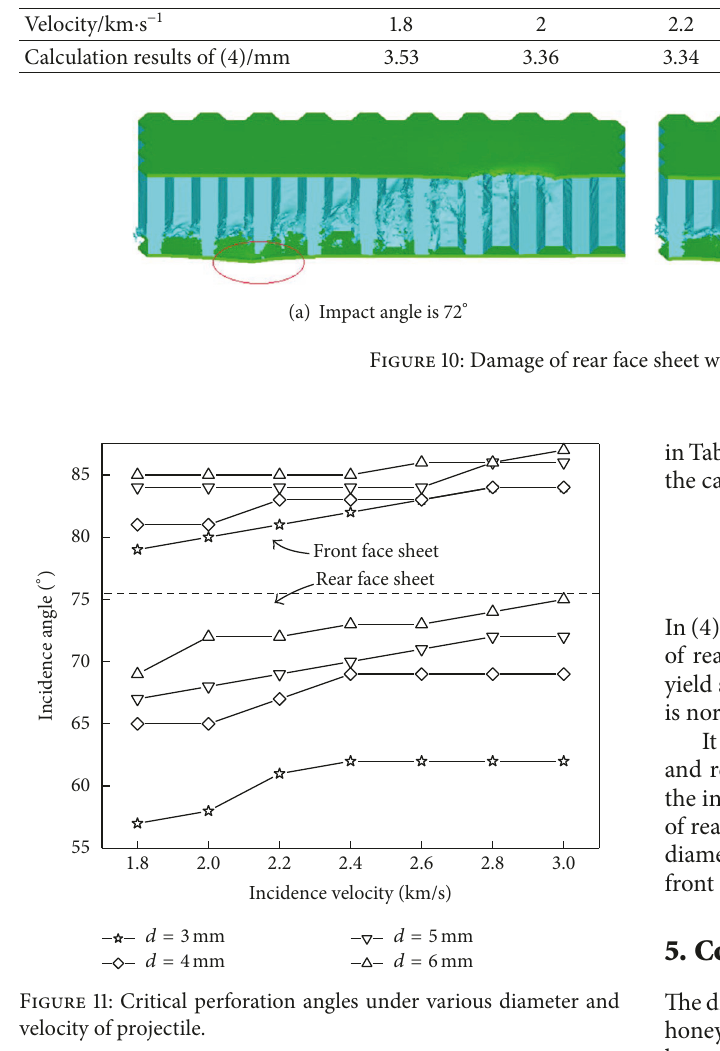
Table 6: Particle diameter at ballistic limit (the particle diameter of simulation was 3 mm).